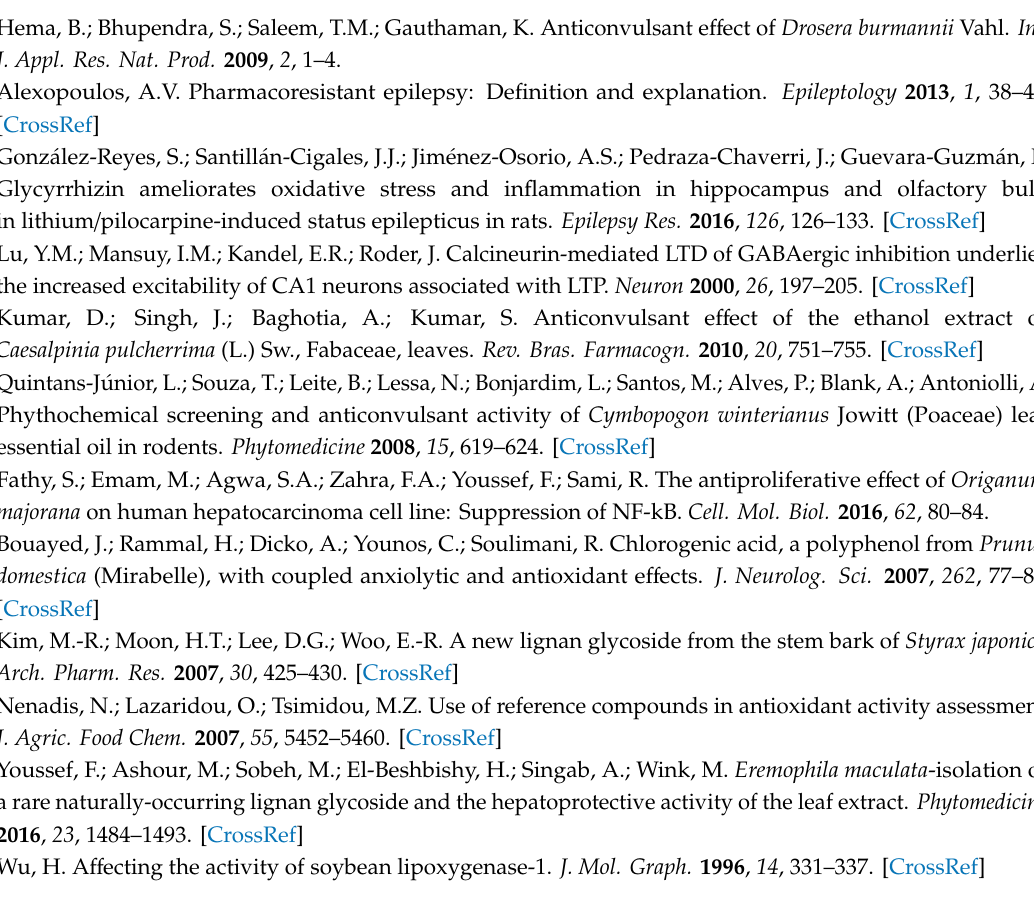
Figure S1: NMR data of Pinoresinol-4- O - β - d